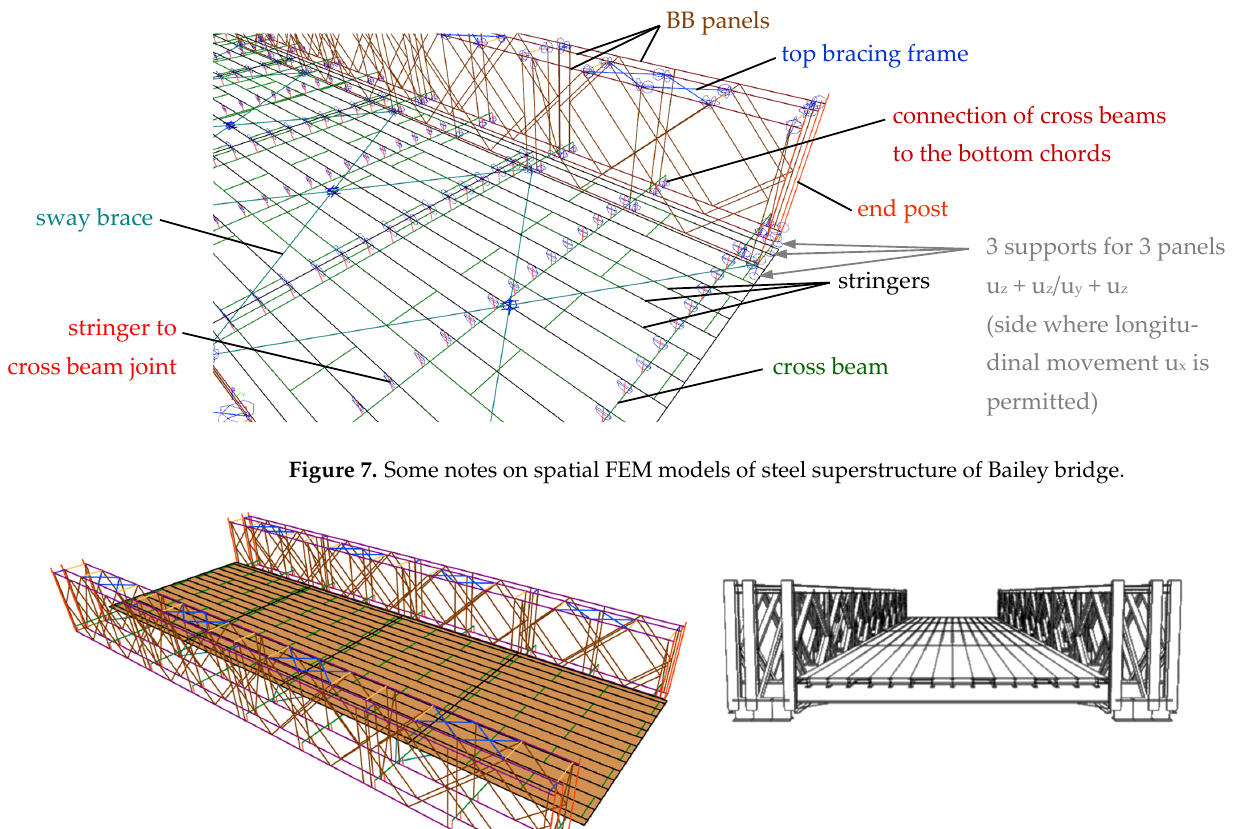
Figure 7. Some notes on spatial FEM models of steel superstructure of Bailey bridge.